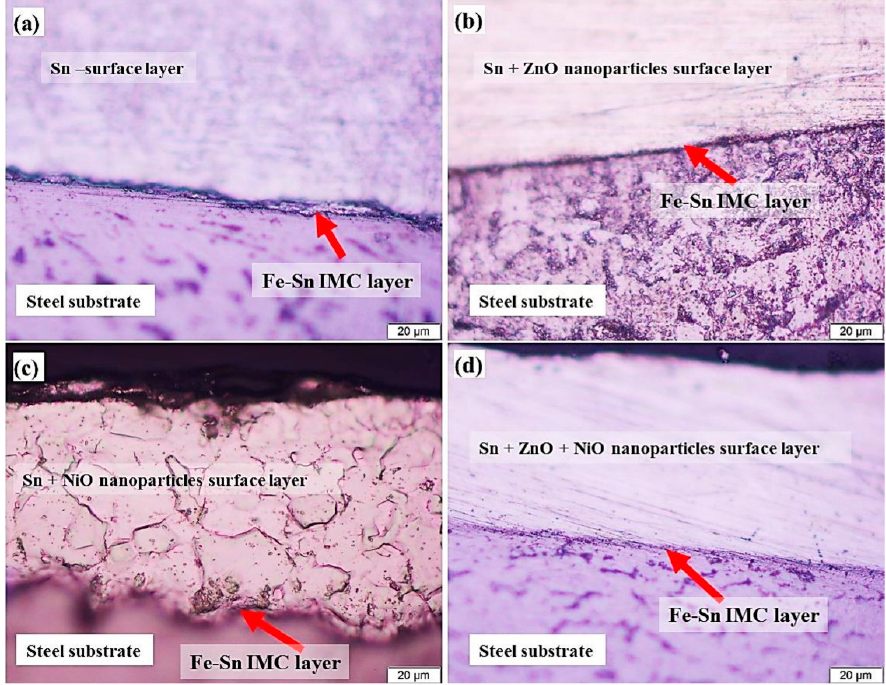
Figure 6. Micrography of four distinct covered substrate and interfacial coatings of steel: ( a ) pristine Sn covering (S1); ( b ) Sn+ ZnO NPs covering (S2); ( c ) Sn+ NiO NPs covering (S3); and ( d ) Sn + ZnO + Sn covering (S1); ( b ) Sn + ZnO NPs covering (S2); ( c ) Sn + NiO NPs covering (S3); and ( d ) Sn + ZnO + NiO NPs covering (S4). Reprinted with permission from Ref. [45] MDPI (2022). NiO NPs covering (S4). Reprinted with permission from Ref. [45] MDPI